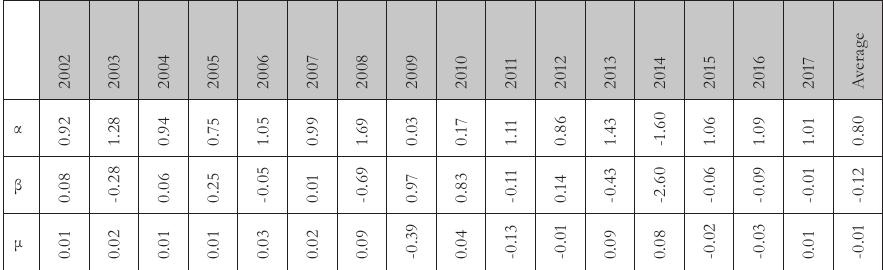
Tab. 3 – Marginal indicators of the allocation of household income in Ukraine in 2002-2017. Source: own research